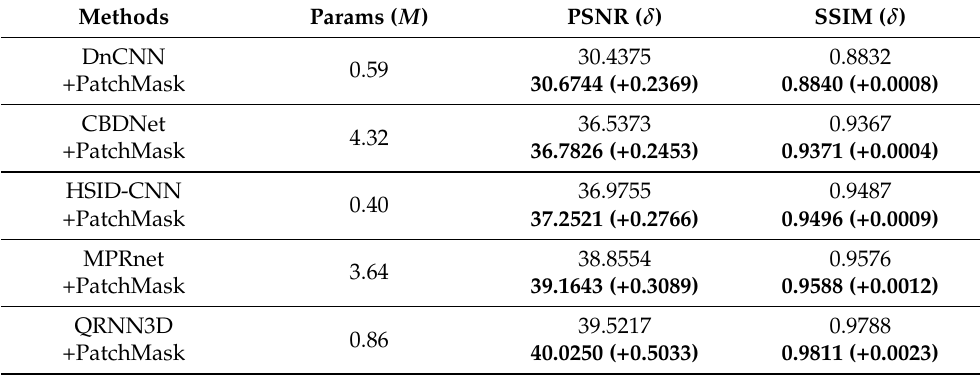
Figure 14. The results of the original model and the network trained after adding our DA method on the ICVL dataset. The 20th band of the image was selected for comparison. Table 3. The effects of DA methods on the performance of network models with different parameters. δ represents an increased value. Best scores are highlighted. For the convenience of reading, we bold the best results of different methods in the same